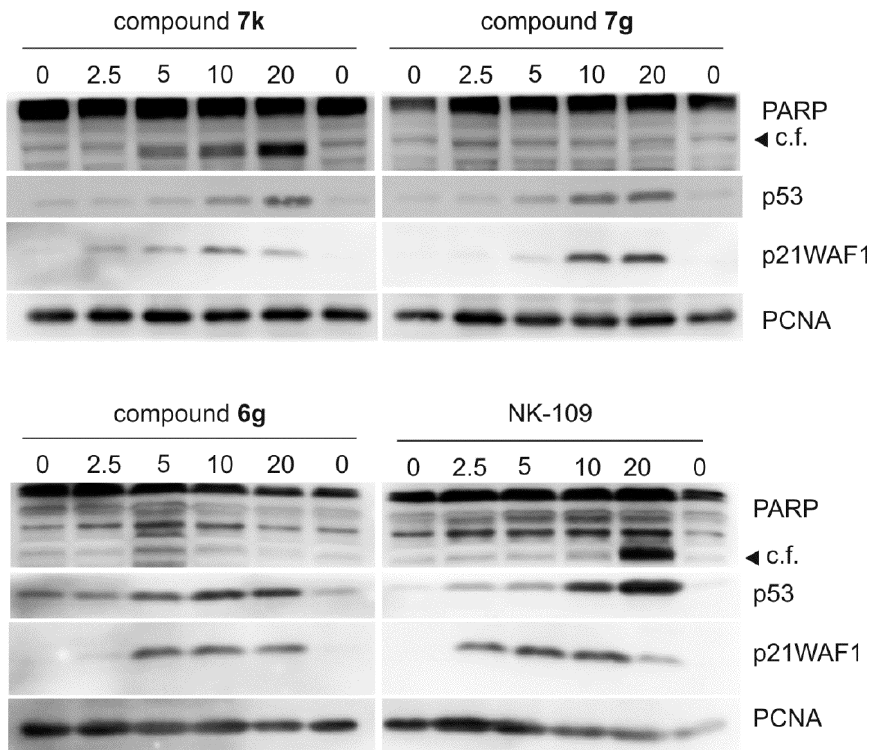
Figure 4. Dose-dependent effect of compounds 7k , 7g , 6g and NK-109 on p53 and its activity in MCF-7 cells. The cells were treated for 24 h with indicated doses of compounds (given in µM) and then specific proteins were analyzed by immunoblotting as described in the Materials and Methods section. C.f., 89 kDa cleavage fragment of PARP.